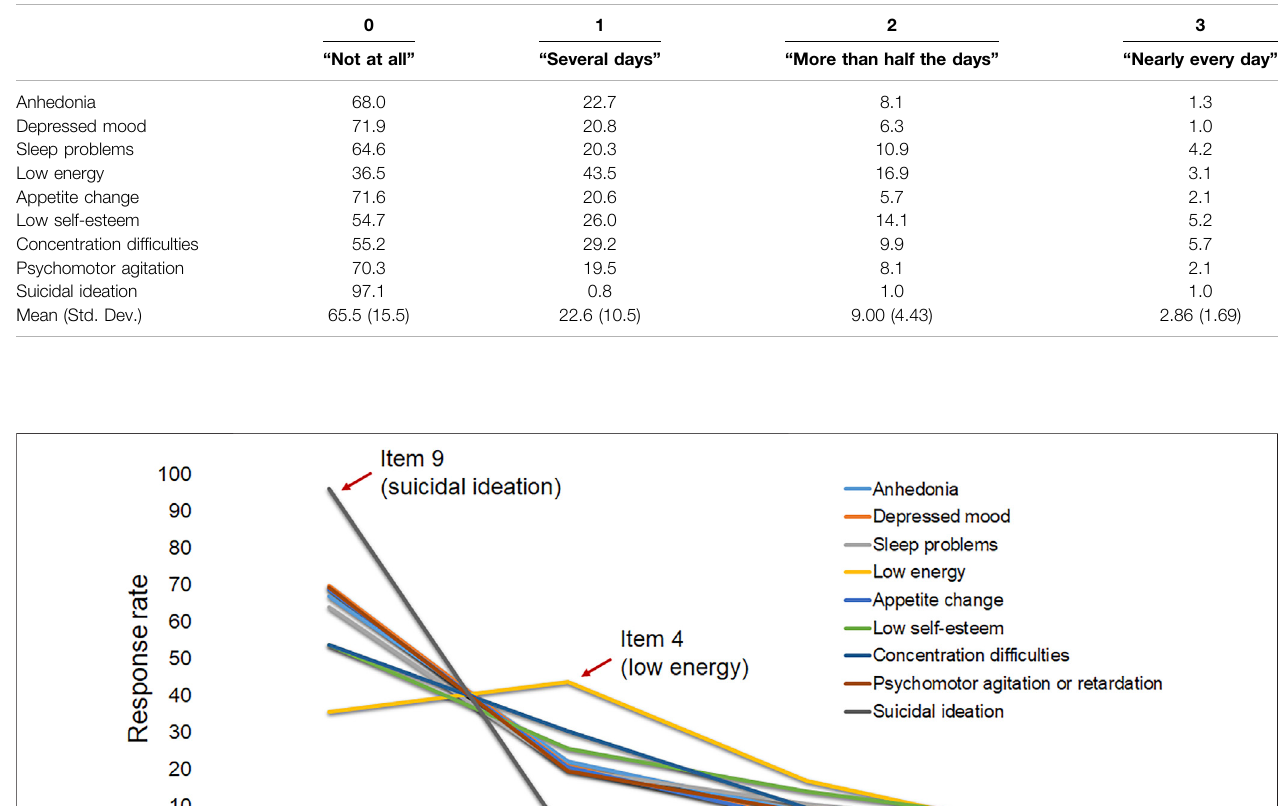
TABLE 2| T-PHQ-9 item responses listedaspercent monastics endorsingeach responseoption. Each oftheitems isscoredwiththefollowing4-pointresponse options: 0 (not at all), 1 (several days), 2 (more than half the days), and 3 (nearly every day).